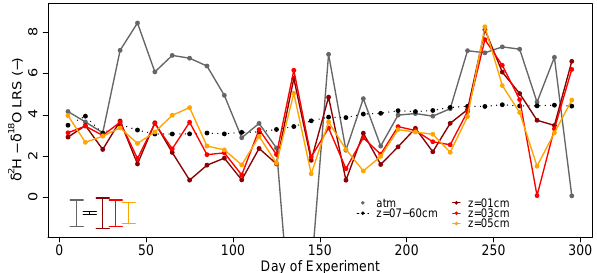
Figure 7. Time course of the slopes of the δ 18 O– δ 2 H linear regres- sions (LRS) for time intervals of 10 consecutive days of atmosphere data (gray solid line), soil data from the upper three layers (1, 3, and 5cm, colored solid lines), and combined soil data from the re- maining bottom layers (from 7 to 60cm, black dotted line). Mean standard errors are represented by the error bars in the bottom left